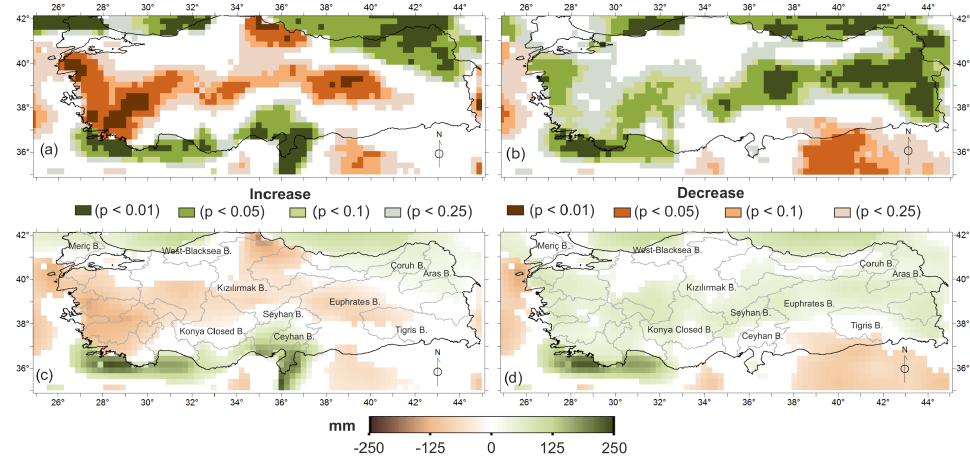
Figure 9. The distribution of the presence and the direction of evapotranspiration (ET) trends by (a) ERA-Interim and (b) Interim/Land. The magnitudes of 32-year total ET trends by (c) ERA-Interim and (d) Interim/Land. The polygons in (c) and (d) delineate the 26 water basins in the country.